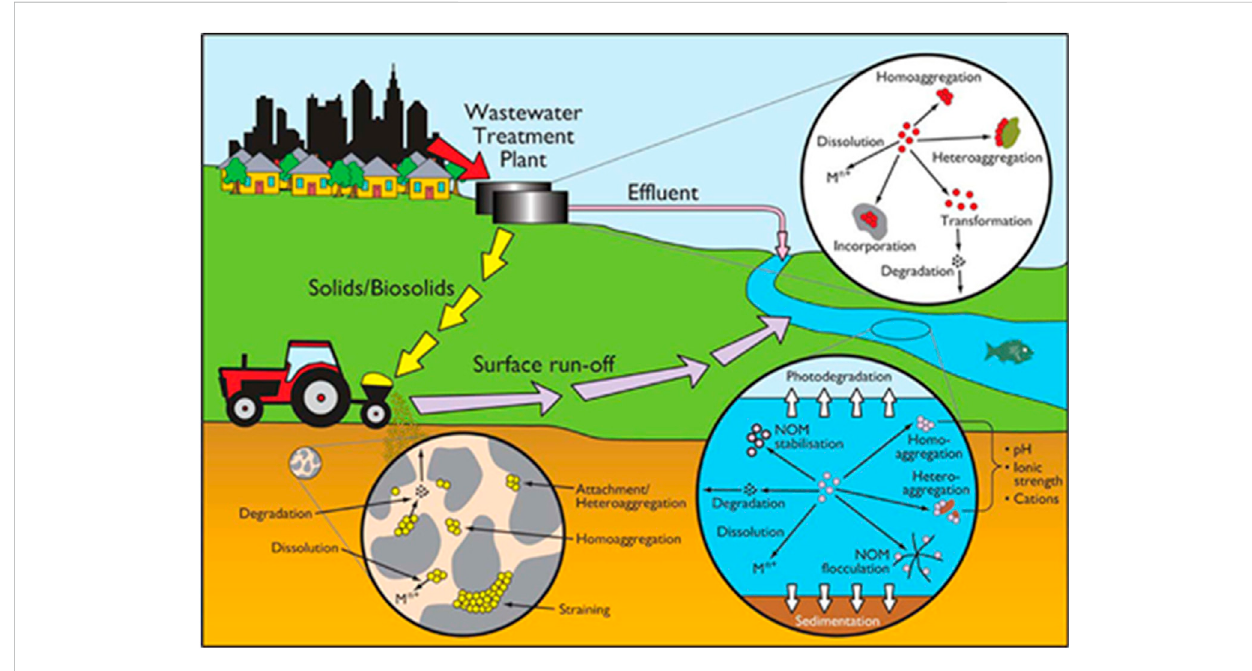
FIGURE 1 Transformation processes of NMs in the environment. Reproduced from (Batley et al., 2013) with permission from ACS